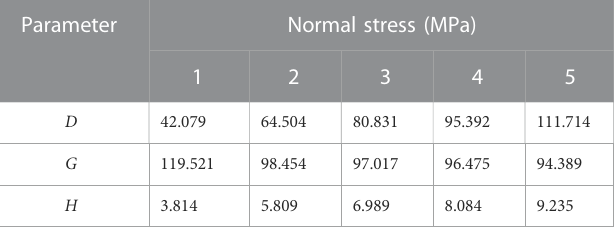
TABLE 8 Values of parameters d , g , and h